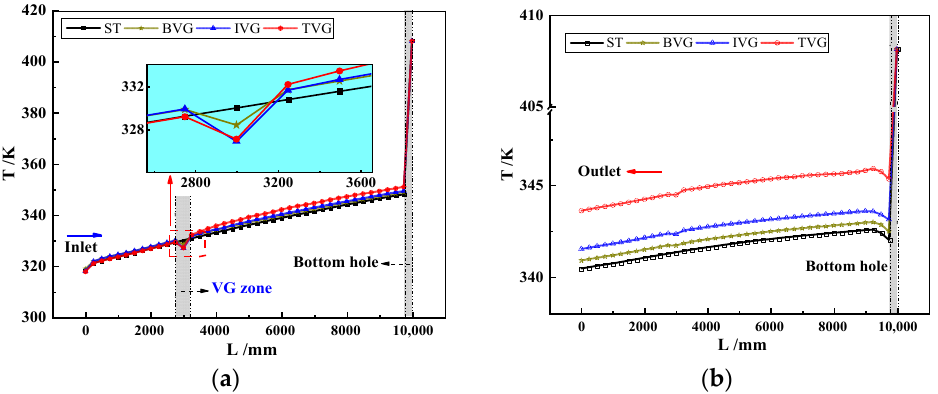
Figure 13. Temperature change curves of fluids in different heat exchanger injection channels and production channels along well depth. ( a ) Inject channel; ( b ) production channel. Figure 14 shows the temperature distribution curves of the four heat exchangers along the radial direction in the region of the vortex generator. This figure shows that the very high fluid temperature of the boundary layer is attributed to the relatively small fluid velocity of the boundary layer near the hot rock wall surface. Furthermore, more energy is absorbed by the hot rock. The thermal conductivity of water is lower; therefore, the fluid’s thermal conductivity in the radial direction is poor and the temperature of the fluid injected into the channel decreases rapidly in the radial direction. According to this figure, the fluid temperature in the production channel is presented as high to low: TVG > IVG > BVG > ST. This arrangement shows that the heat recovery of the TVG heat exchanger effect is the best, and the heat recovery efficiency of the coaxial heat exchanger is improved.